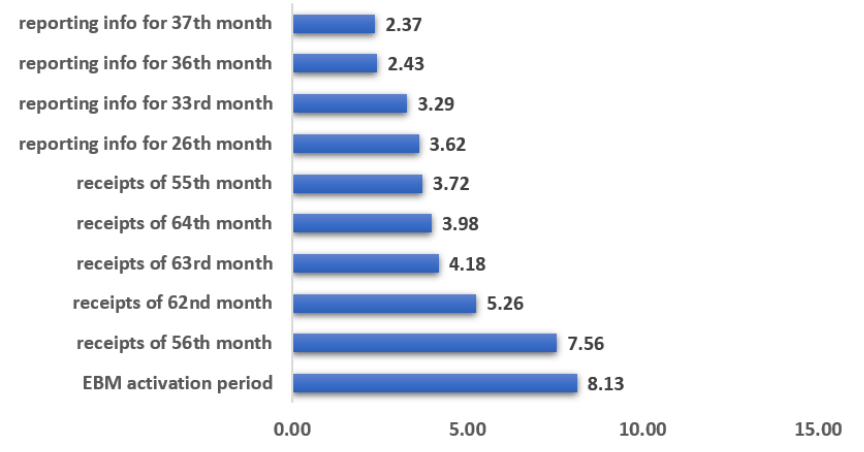
Figure 2. Relative importance of the top 10